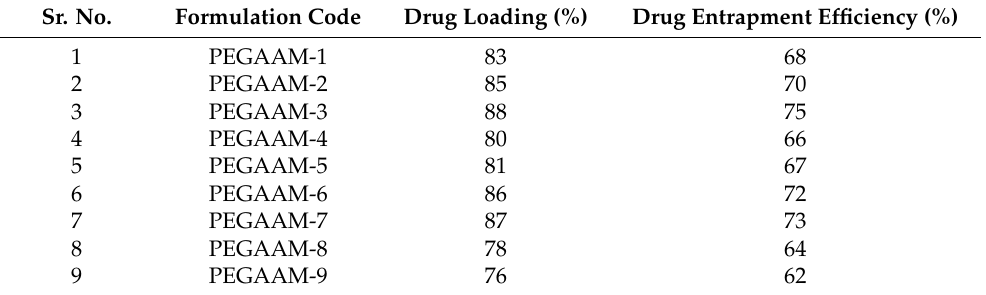
Table 2. Drug entrapment efficiency.